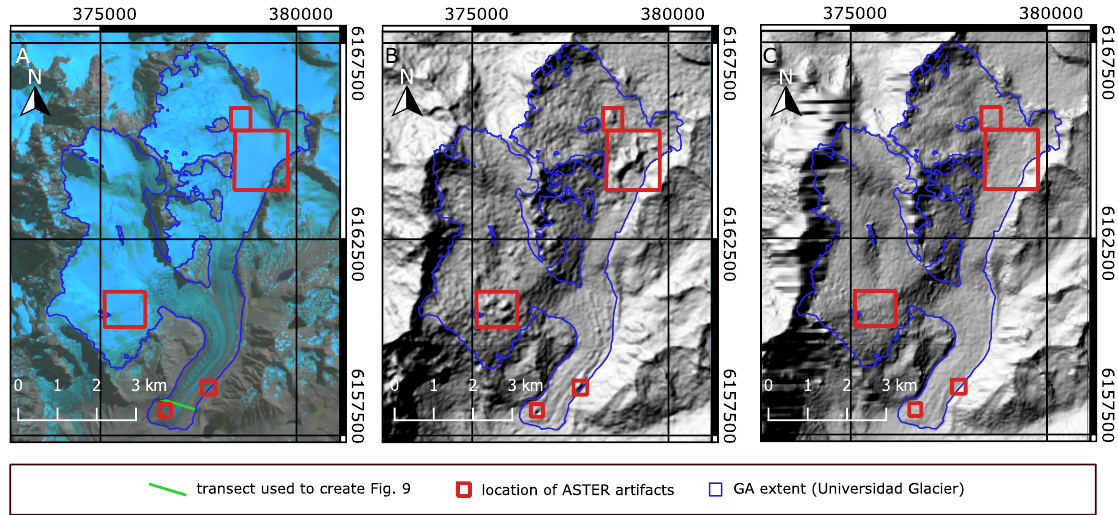
Figure 2. Artifacts of ASTER DEM on Universidad Glacier: ( A ): ASTER true-color composition (9 April 2003); ( B ): ASTER DEM hill-shade; ( C ): SRTM DEM